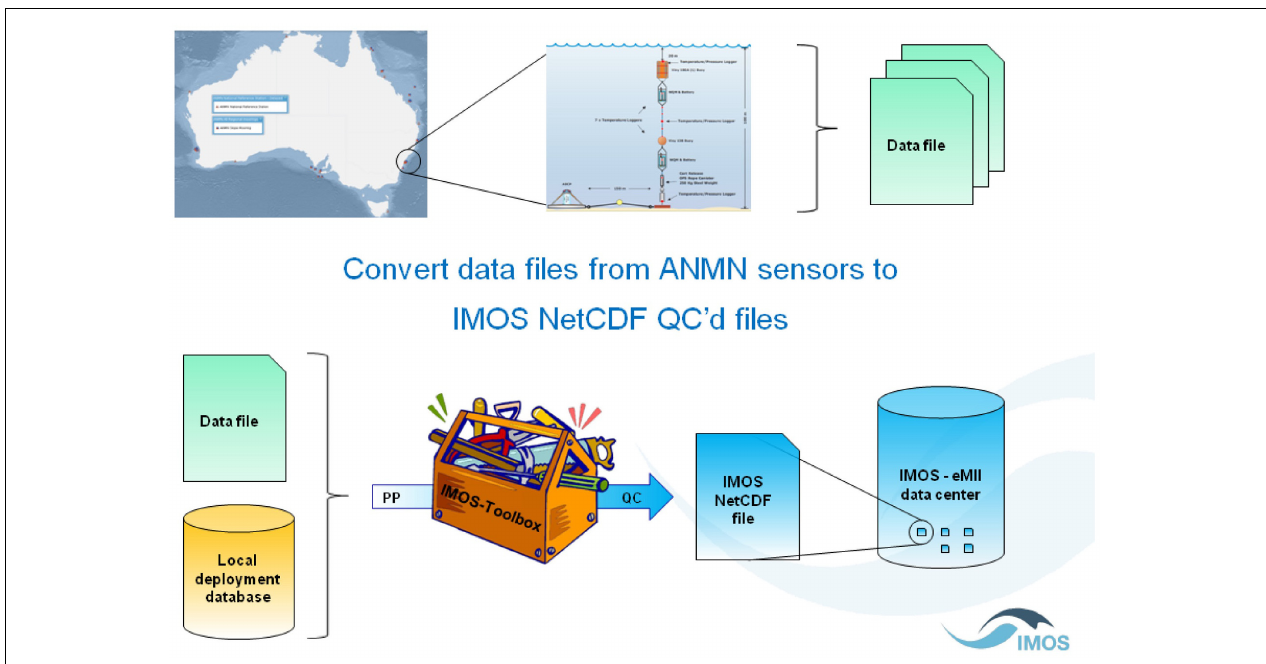
FIGURE 5 | IMOS moorings data production workflow. Source: the imos-toolbox GitHub wiki